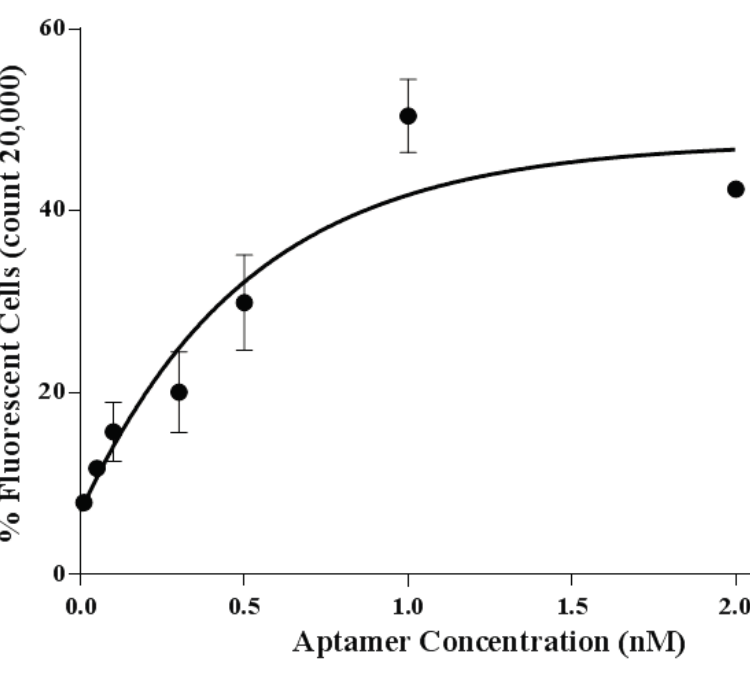
Figure 4. Binding affinity analysis of aptamer A14.